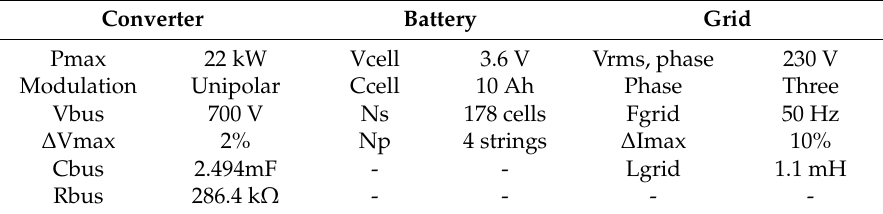
Table 8. Main characteristics of the Heavy-Duty system connected to HV Batteries.